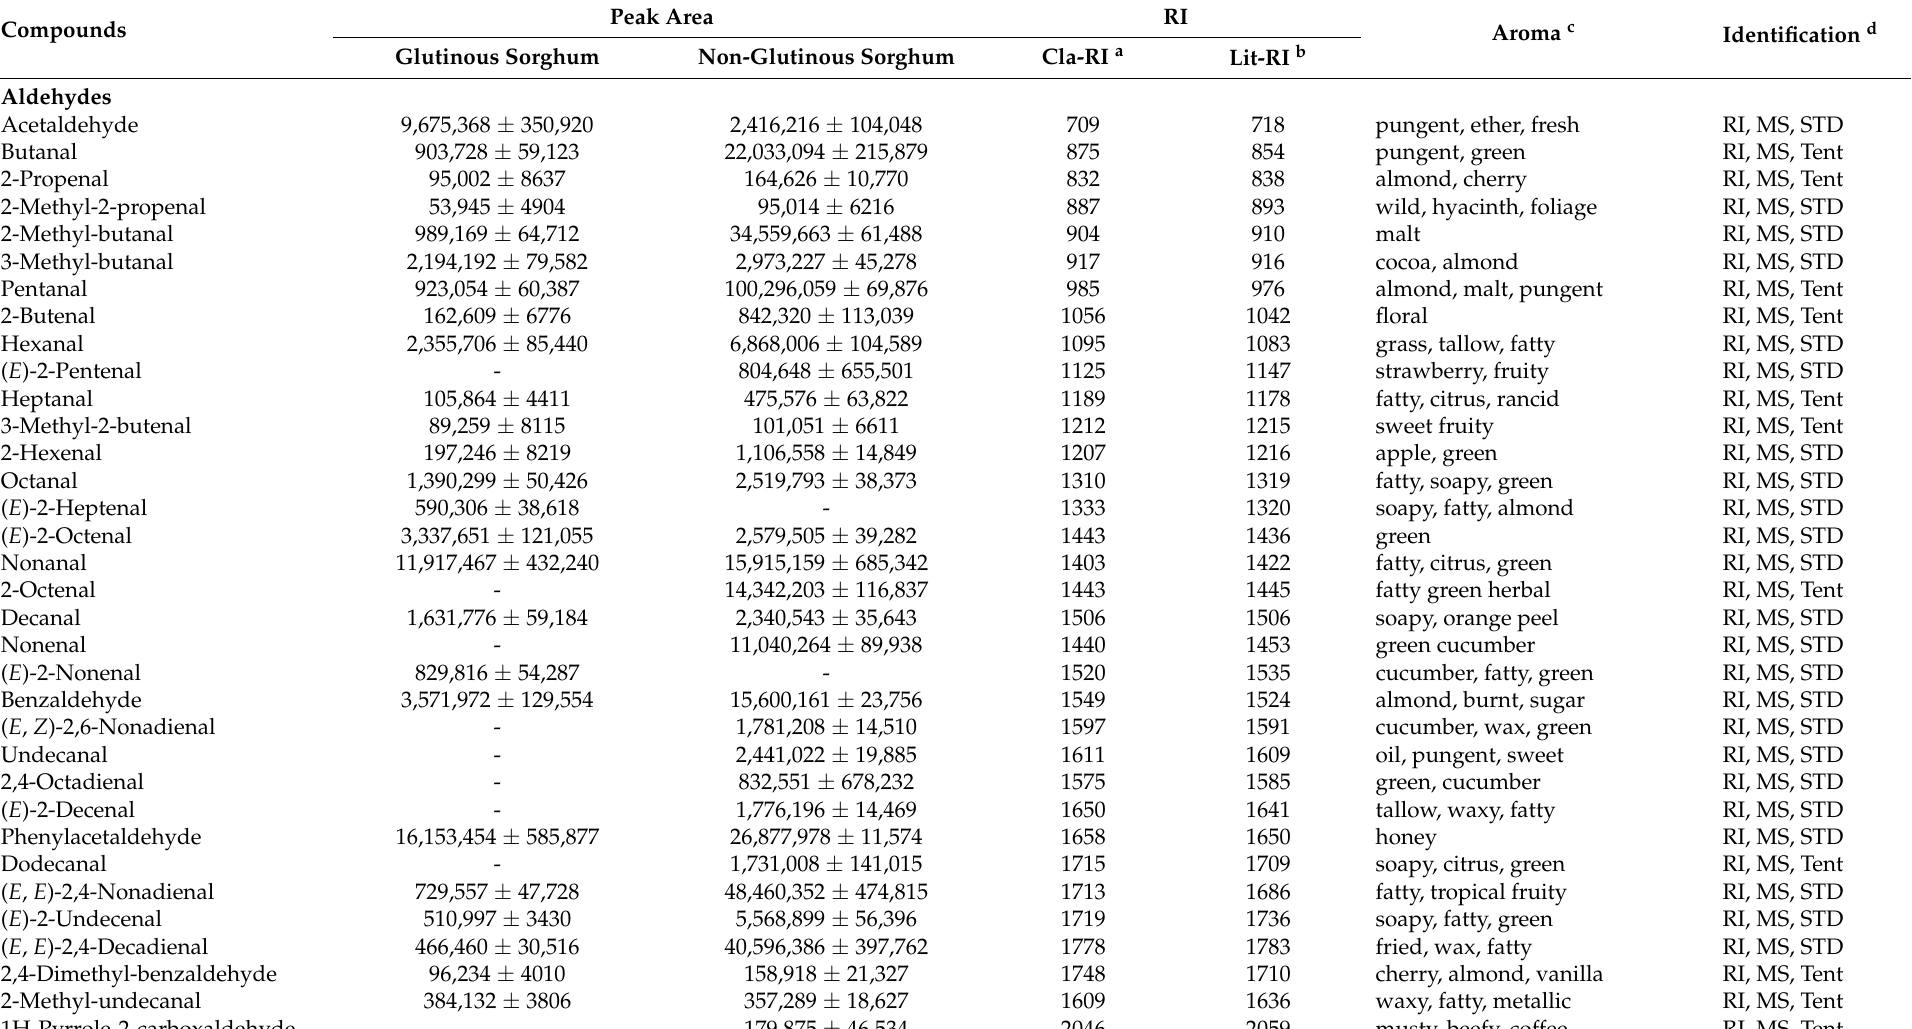
Table 2. Volatile compounds identified in cooked glutinous and non-glutinous sorghums by HS-SPME-GC ×